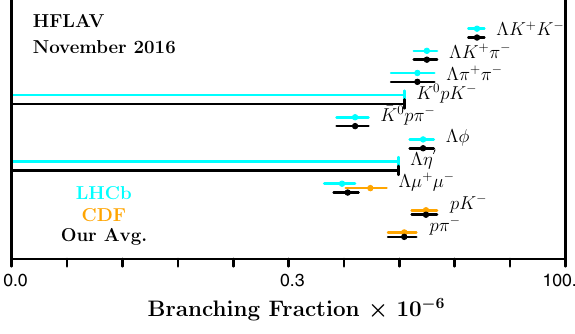
Fig. 179 Branching fractions of charmless Λ 0